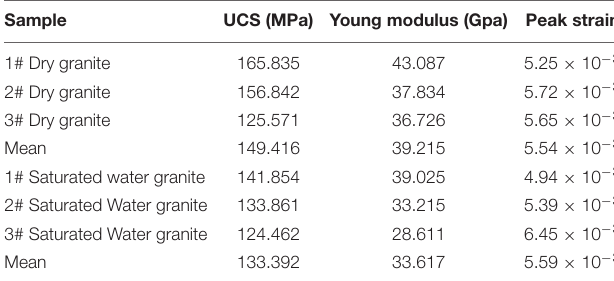
Frontiers in Earth Science |